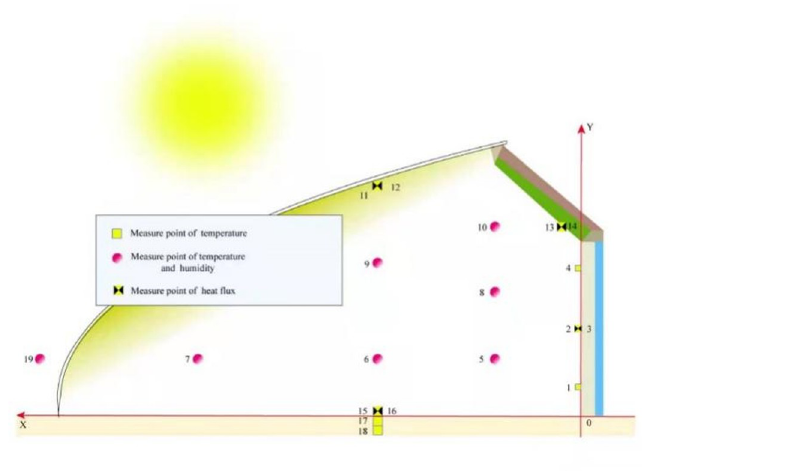
Fig 3. Layout of temperature and humidity